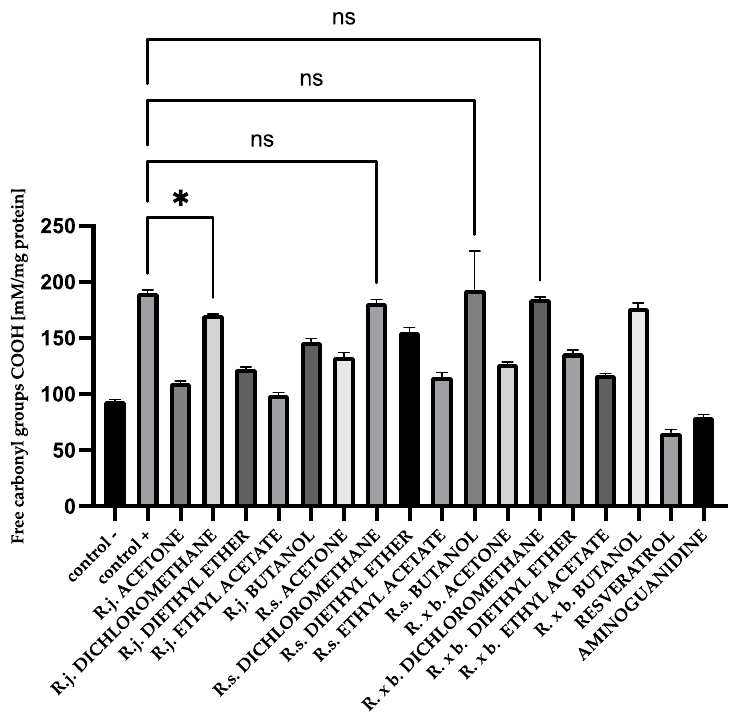
Figure 7. The effect of extracts on the in vitro formation of COOH groups in HSA glycation. R.j., R.s., and R. × b. mean Reynoutria japonica , Reynoutria sachalinensis , and Reynoutria × bohemica , respectively. Error bars shown in this figure are means ± SD for n ≥ 5. * Statistically significant at p ≤ 0.05 compared to control +; ns—not statistically significant at p ≤ 0.05. All other results are statistically significant at p ≤ 0.0001 compared to control +. Detailed information can be found in the Supplementary Material.